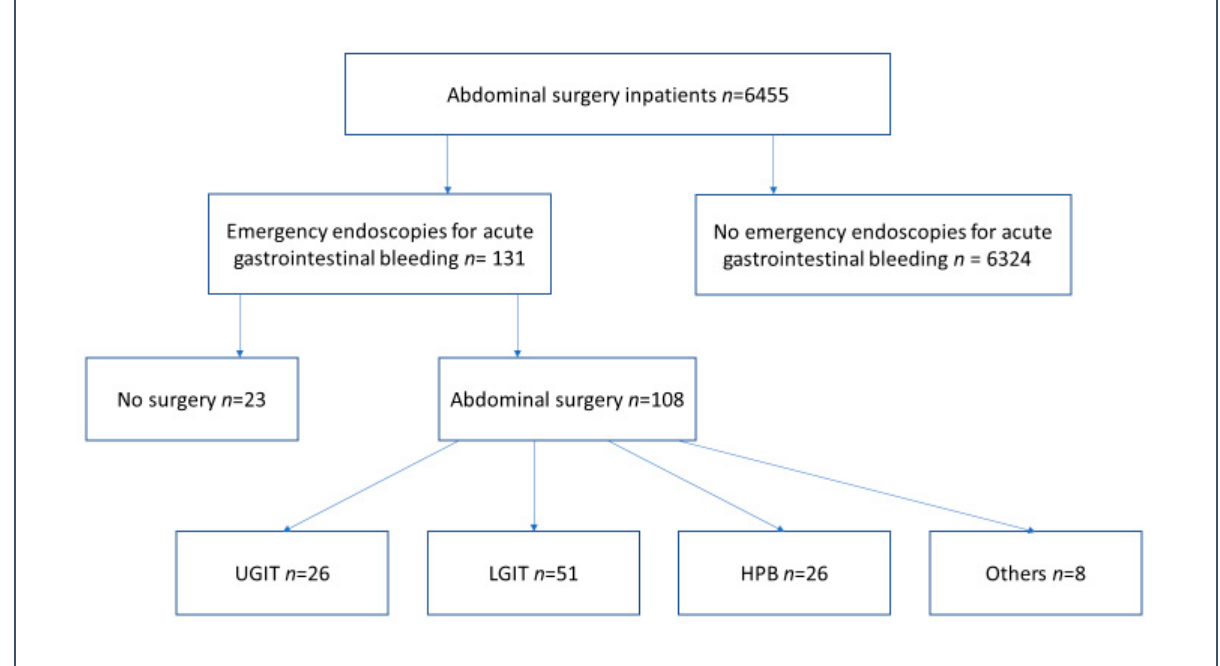
Figure 1. Patient’s distribution into the four groups regarding the operation area. The localization of bleeding detected during emergency endoscopy was found in the UGIT in n = 46 (52.87%), in the LGIT in n = 18 (20.69%), and in the HPB system in n = 25 (28.73%) patients. In further detail, anastomotic bleeding that led to emergency endoscopy was found in n = 10 (11.49%). In relation to the associated surgical site, 22.22% of patients